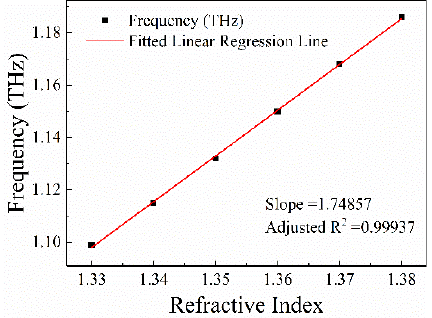
Figure 6. Variation of resonance frequency with different RIs of bioanalyte.